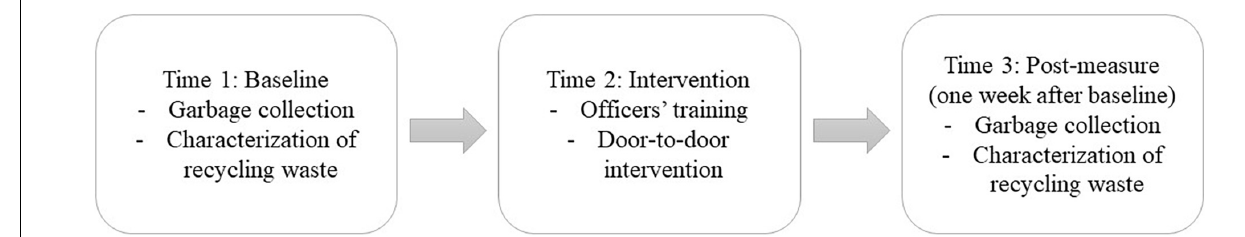
FIGURE 1 | Overview of psycho-environmental intervention.